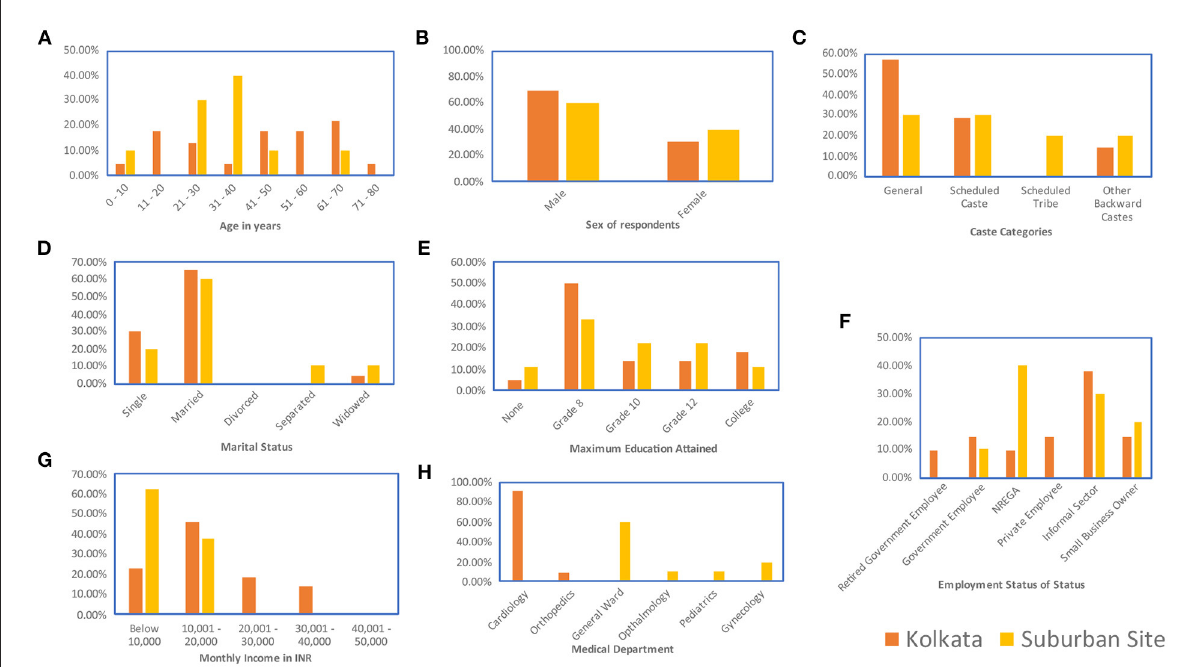
FIGURE3 Demographic data for patient respondents: (A) Age (B) Sex (C) Caste (D) Marital Status (E) Maximum level of educational attainment (F) Employment status, including patients employed under a 100 day right-to-work employment guarantee provided by the Indian